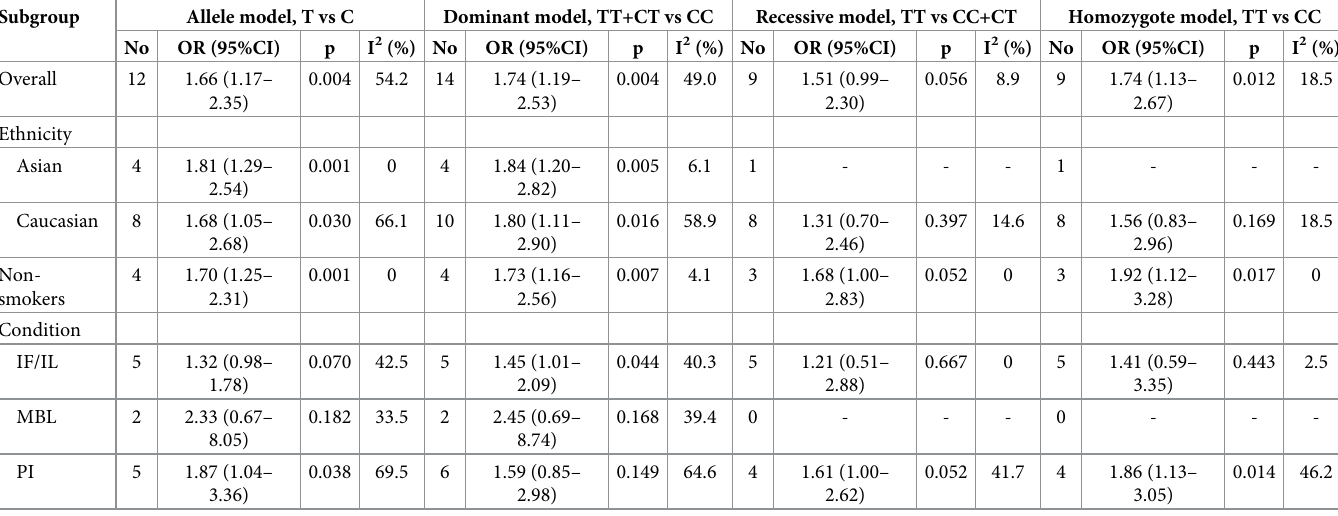
Table 3. Association between IL-1 β C+3954T polymorphism and susceptibility to peri-implant